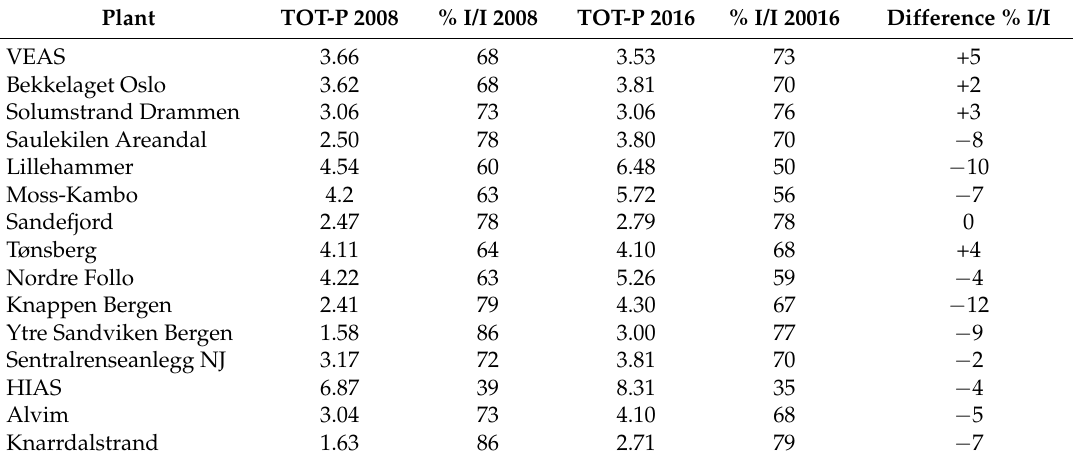
Table 5. Measured amounts of TOT-P and calculated percentages of I/I-water for wastewater plants in Norway for 2008 and